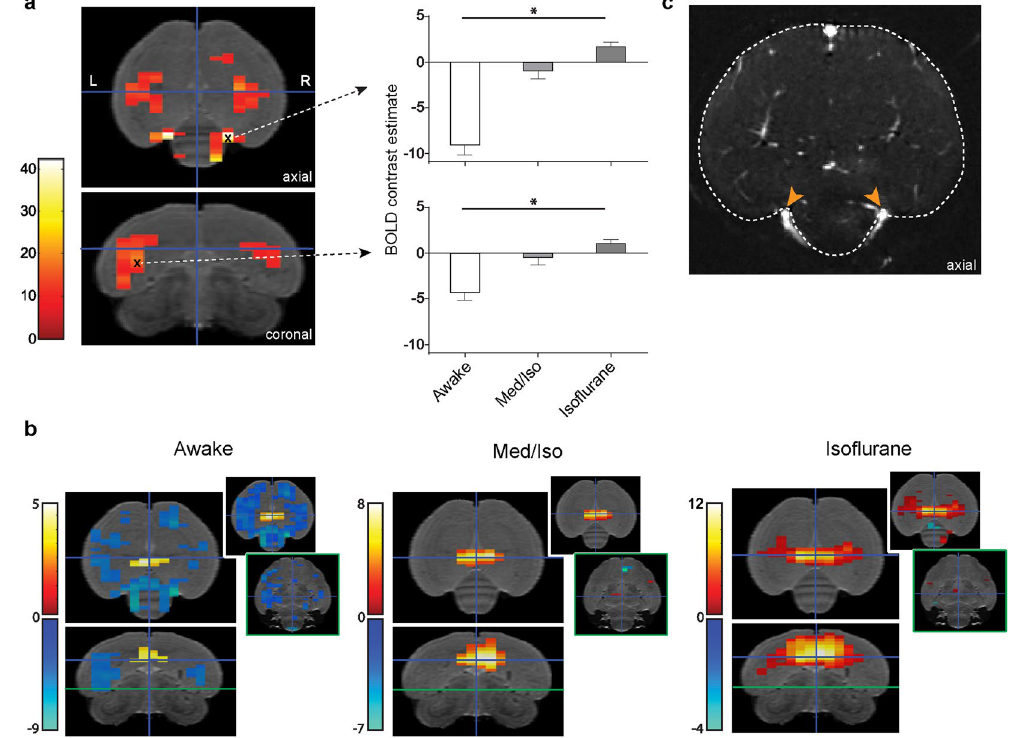
Figure 4. Comparison of the BOLD response to auditory stimulation in awake vs anaesthetized conditions. ( a ) Main effect of condition. ( b ) Detailed graphs for 2 individual voxels within the main effect (voxels marked in ( a ) with ‘x’). The bars represent the mean BOLD response amplitude ( ± SEM) for all stimuli vs rest in the different conditions. ( b ) Positive (red/yellow) and negative (blue/green) BOLD responses to all stimuli in the different conditions. The statistical maps in ( a ) and ( b ) are superimposed on coronal and axial slices of the population based template. Only significant voxels ( p uncorrected < 0.001; cluster extent > 12 voxels) are displayed in the main figures. The insets in ( b ) represent statistical maps at a lower threshold ( p uncorrected < 0.01; no cluster extent threshold) at two different levels along the dorso-ventral axis as indicated in the coronal figure by the blue and green horizontal lines. ( c ) Representative angiogram of the zebra finch brain. The arrowheads point to large blood vessels near the cerebellum at the location where the peak of the main effect of condition as represented in ( a ) was